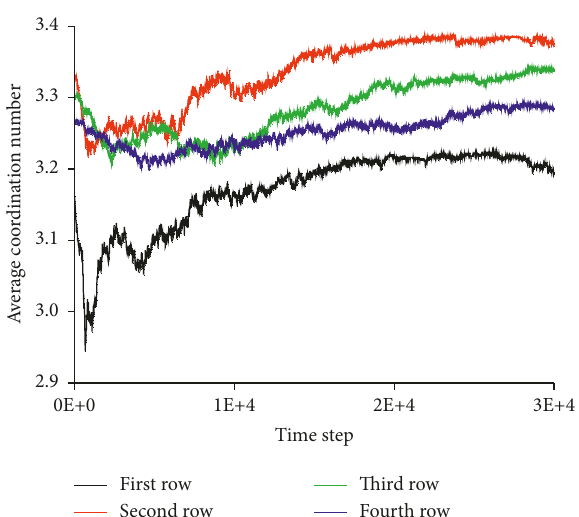
Figure 22: Coordination number above the plate.